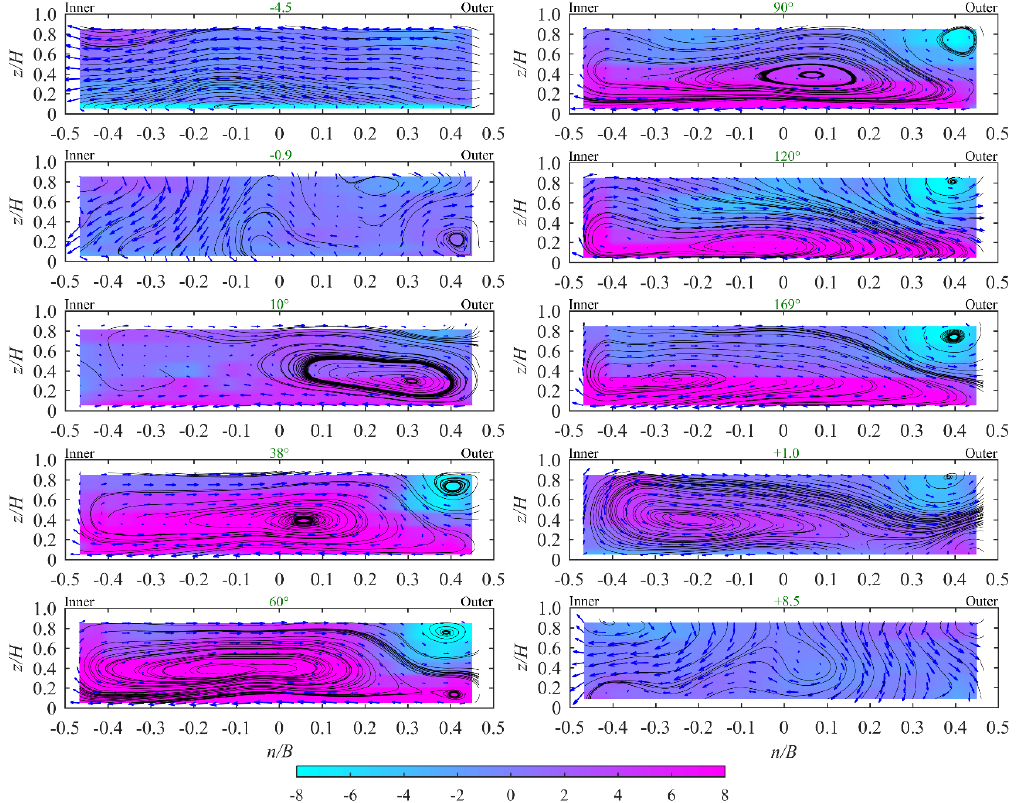
Figure 10. Secondary flow phenomena: velocity projection in the cross-sections (blue vectors); the 2D streamline patterns of the cross-flow (the black line); the dimensionless values of the vorticity (color).